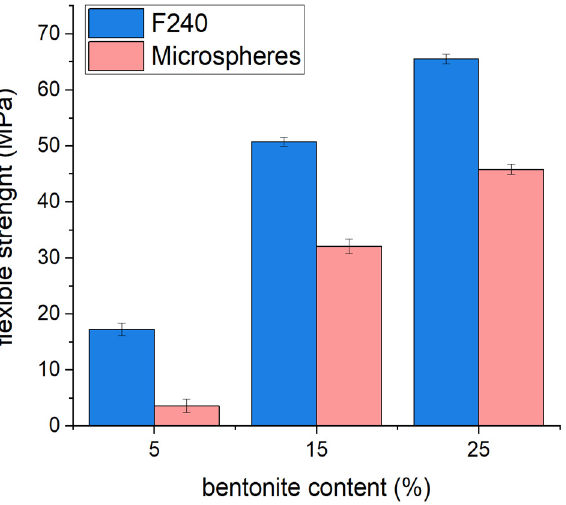
Figure 11. Flexible strength of ceramics produced with electrocorundum F240 of hollow alumina microspheres as fillers vs. bentonite binder content in them. Direct casting, sintering at 1300 °C.